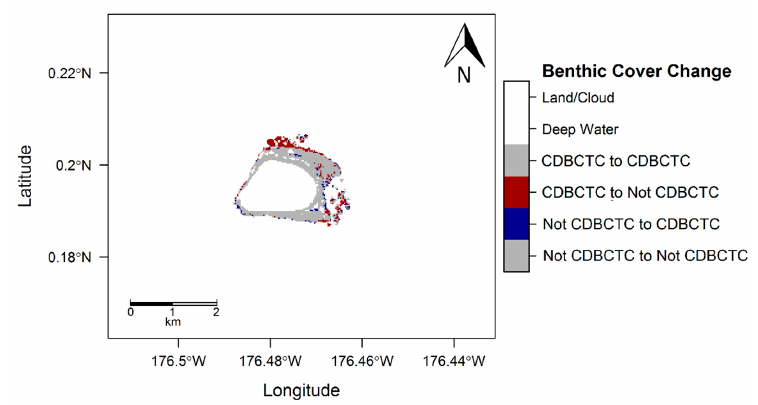
Figure 10. Di ff erence in predicted class membership map for the Palmyra Atoll area of interest for 2002 initial state compared to 2014 final state.